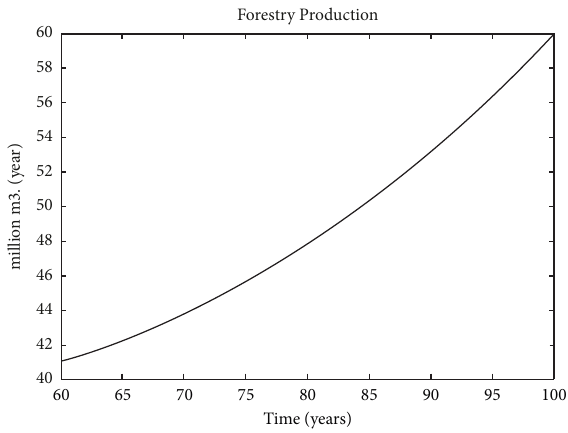
Figure 2: Graphical representation of million · m 3 /year.